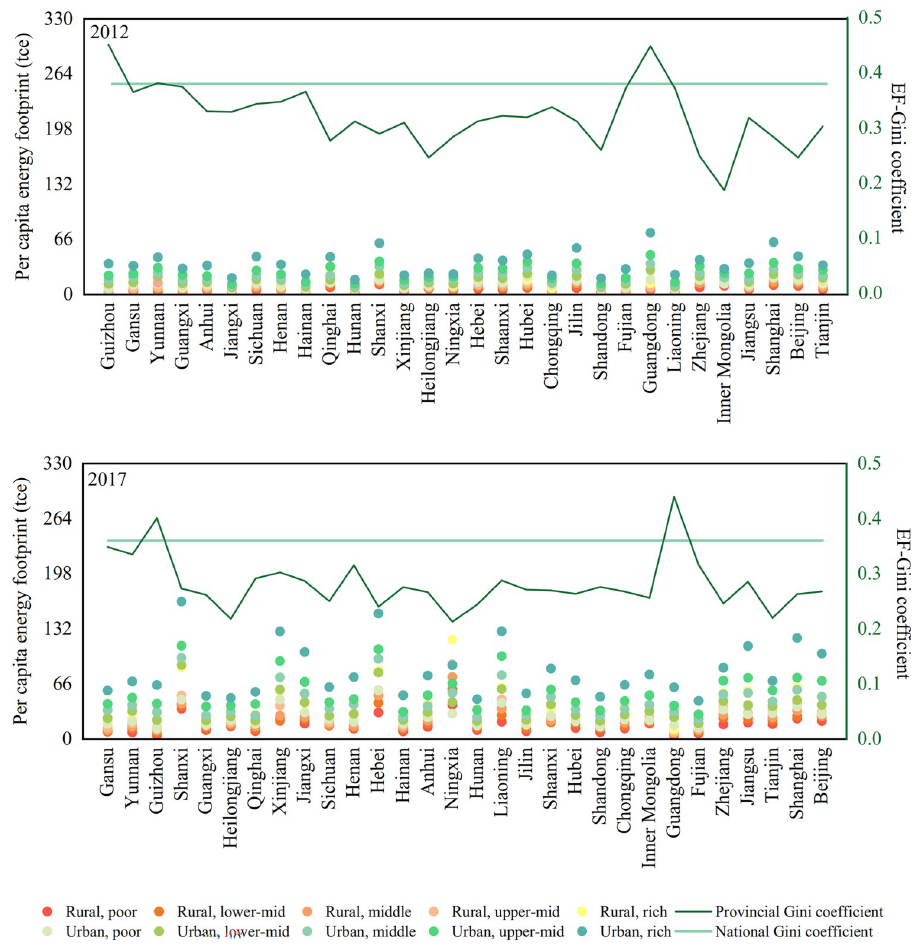
Fig 4. The PCHEF of different income groups and EF-Gini of each province. All provinces are ranked based on GDP per capita, from left to right, from the poorest province with the lowest GDP per capita (Guizhou in 2012, Gansu in 2017) to the highest (Tianjin in 2012, Beijing in